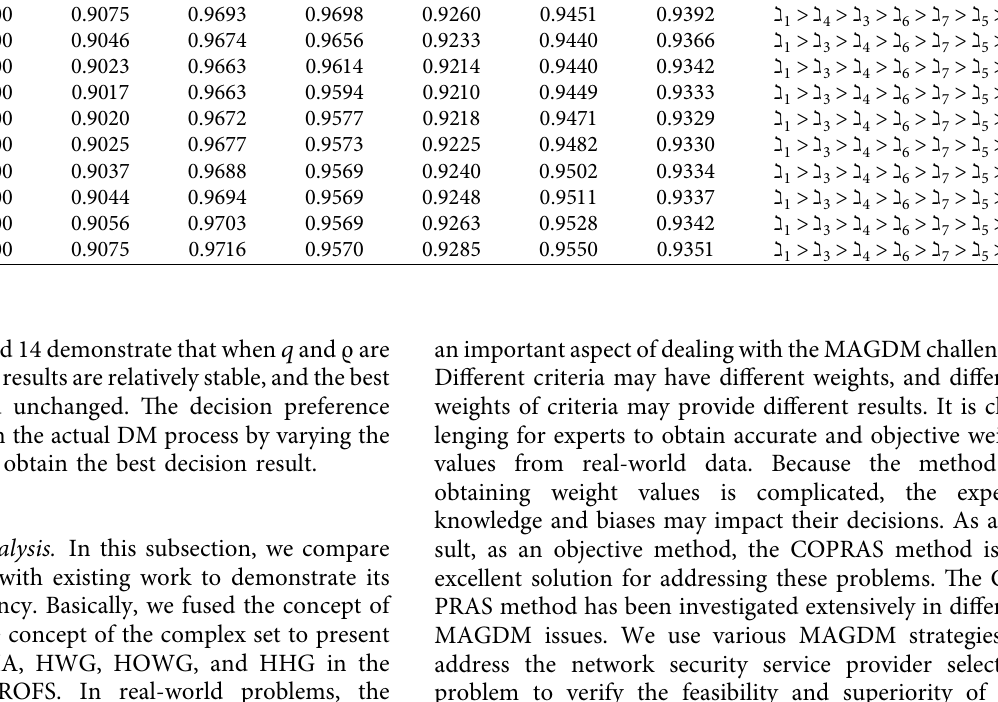
Table 14: Score values and ranking outcomes according to the parameter ϱ by the 2TLC q -ROFHWG operator.